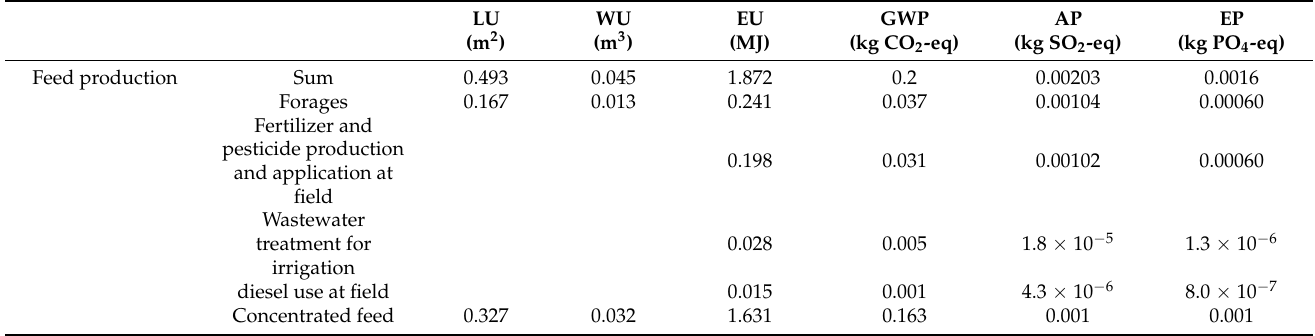
Table 4. Environmental impact of 1 kg FPCM produced by the systems